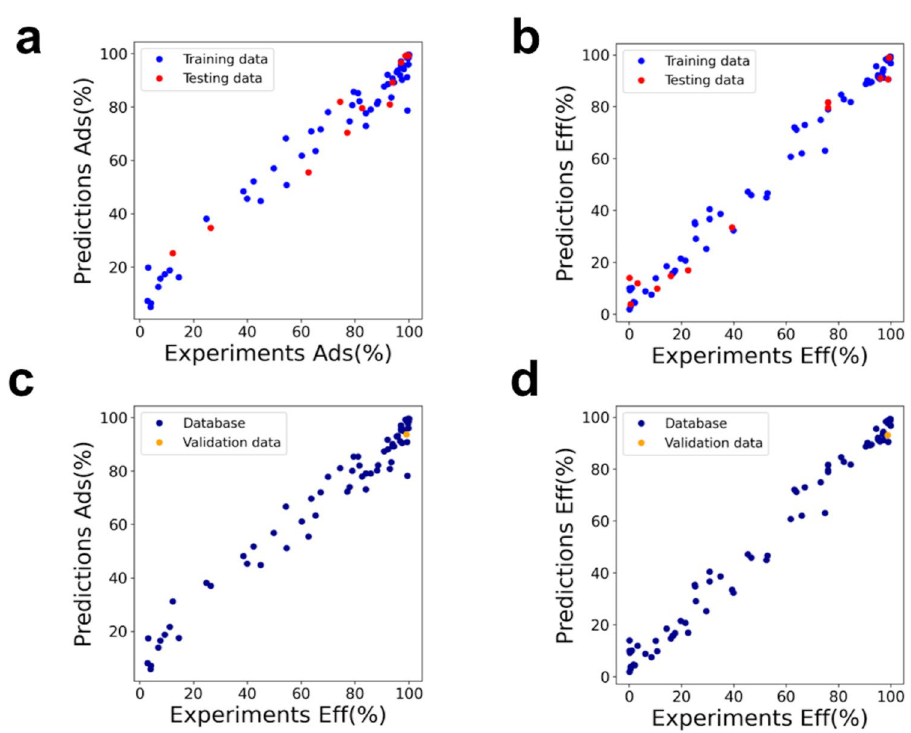
Figure 2. Graphical assessment of RFads ( a ) and RFeff ( b ) of 6 mycotoxins by 15 MDTs under different experimental conditions. Validation of RFads ( c ) and RFeff ( d ) toward one yet-unregulated toxin